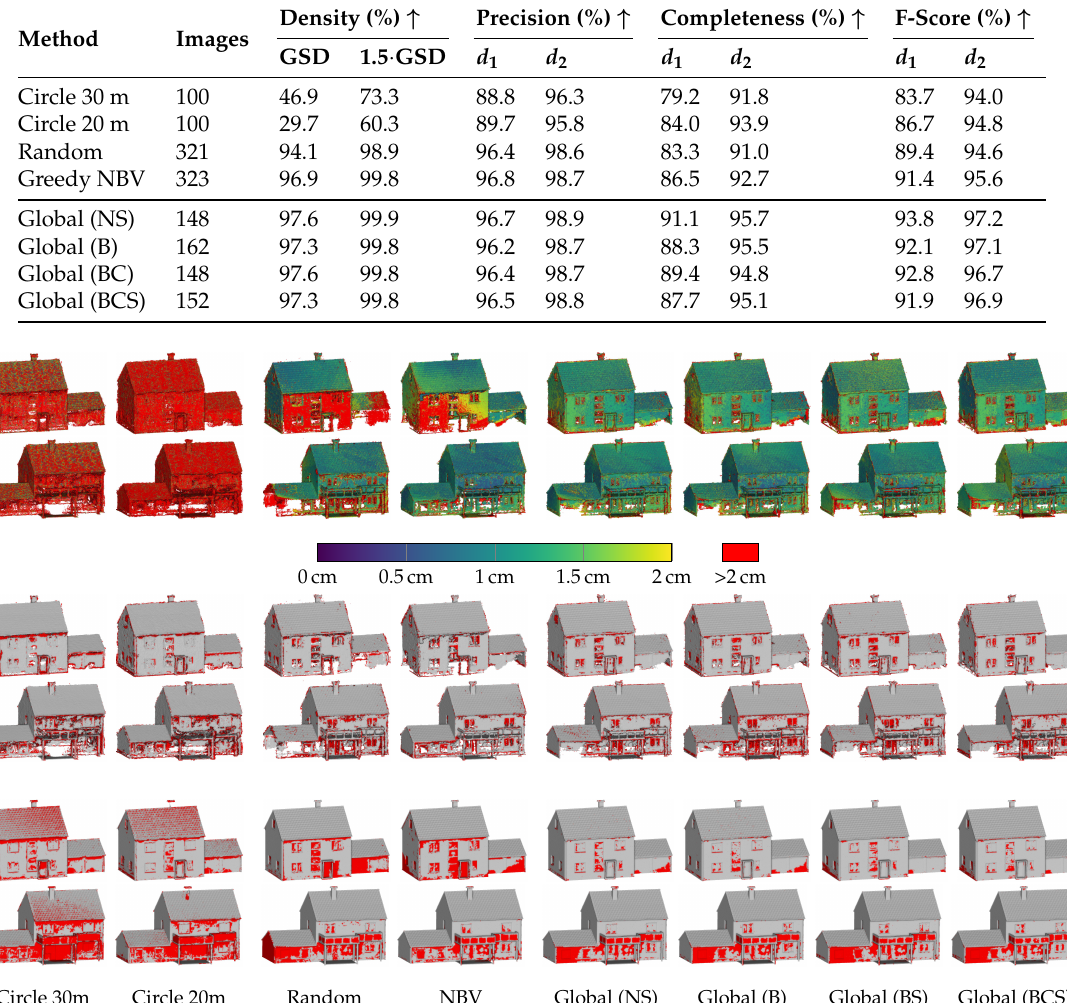
Figure 11. Qualitative comparison of the reconstruction results on a dense point cloud for the synthetic scene using different methodologies (columns). The first two rows show the point density as colored distances towards adjacent points on the front and rear side of the building, while red points indicate distances above the required GSD of 2cm. The reconstruction errors of precision and completeness for d = 5cm are visualized in rows three and four, and rows five and six, respectively, wherein red points indicate erroneous